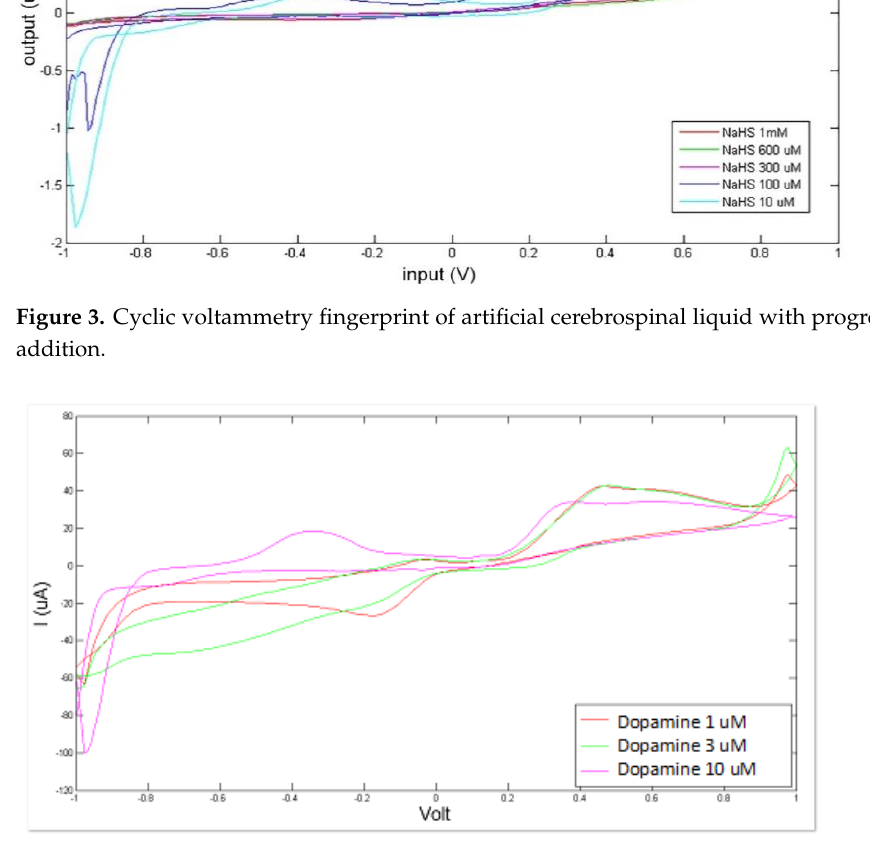
Figure 4. Cyclic voltammetry fingerprint of artificial cerebrospinal liquid with progressive dopamine addition.